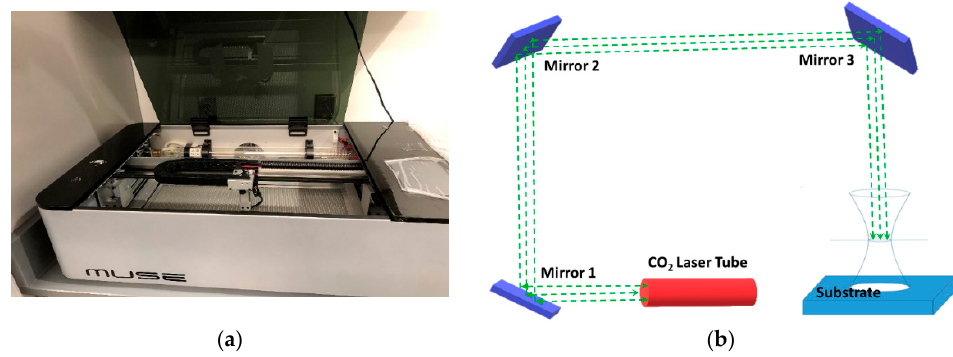
Figure 1. ( a ) Muse commercial CO 2 laser system; ( b ) Schematics of laser beam paths and position of mirrors .